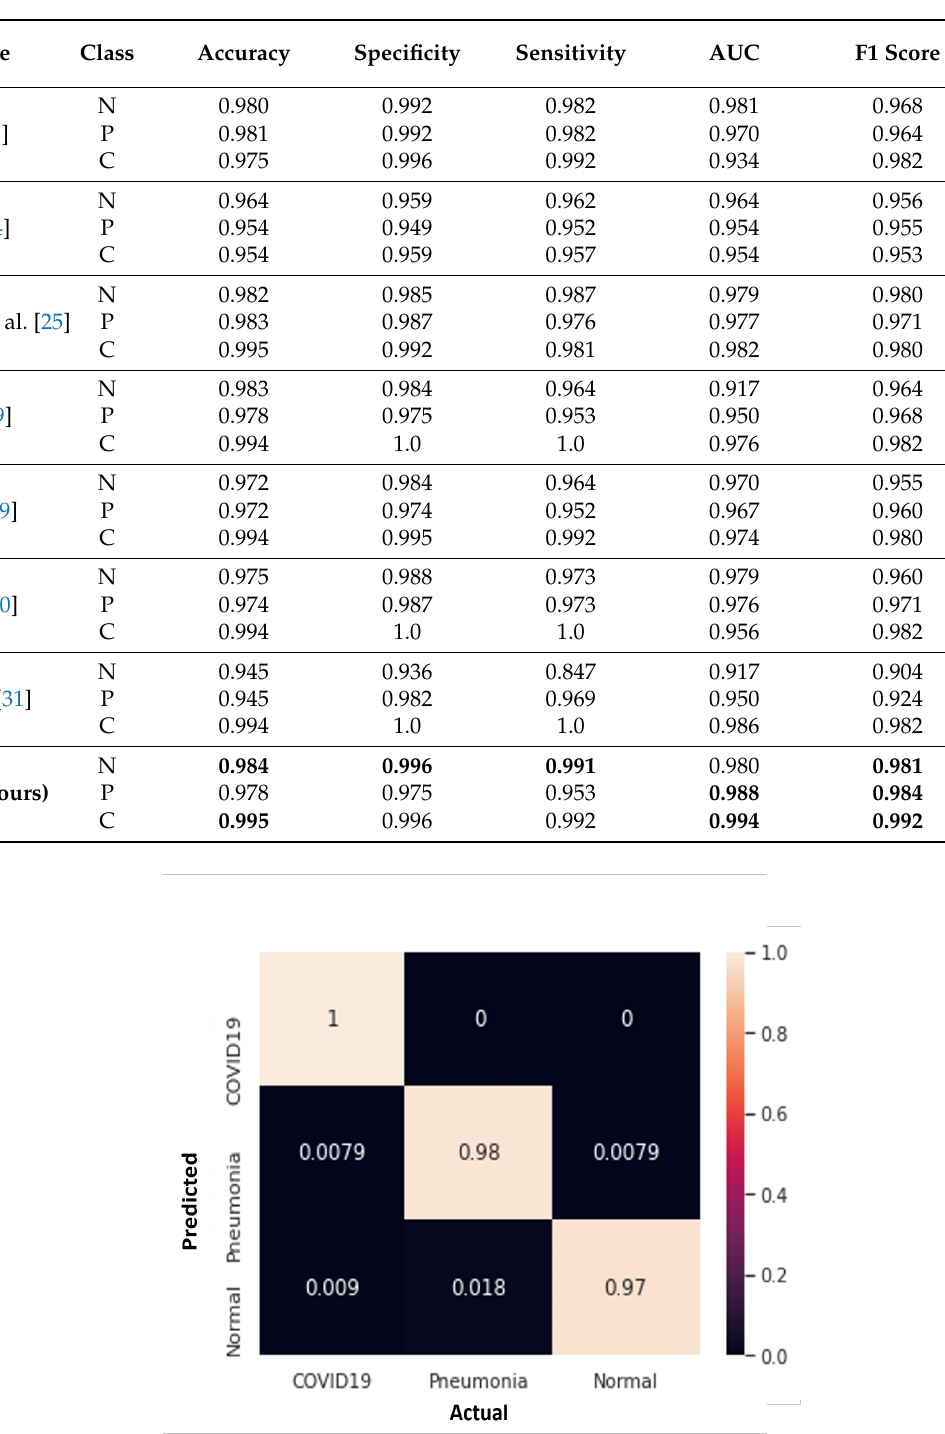
ROC curves to depict overall classification performance of our proposed models in the test dataset, which is very excellent. Table 2. Performance of our proposed approach and other models. N, P and C denote normal, pneumonia, and COVID-19, respectively, and Gen denotes Models Genesis.